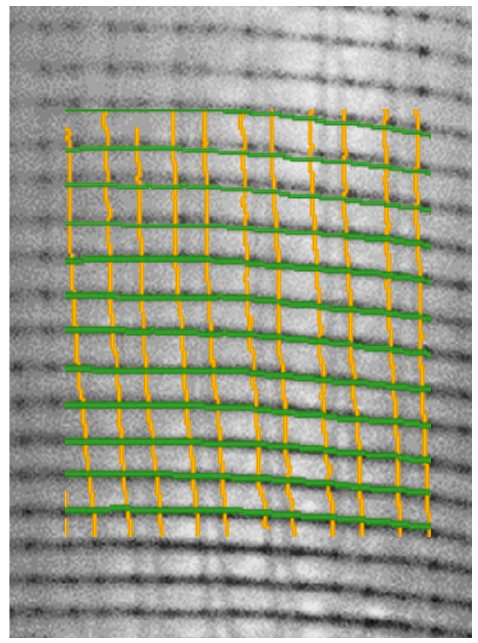
Figure 7. Close-up of the yarn edge detection results.